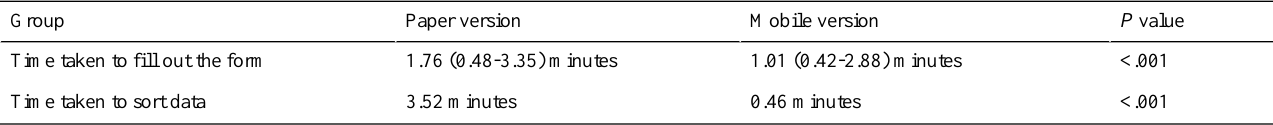
Table 4. Time taken to fill out the form and sort